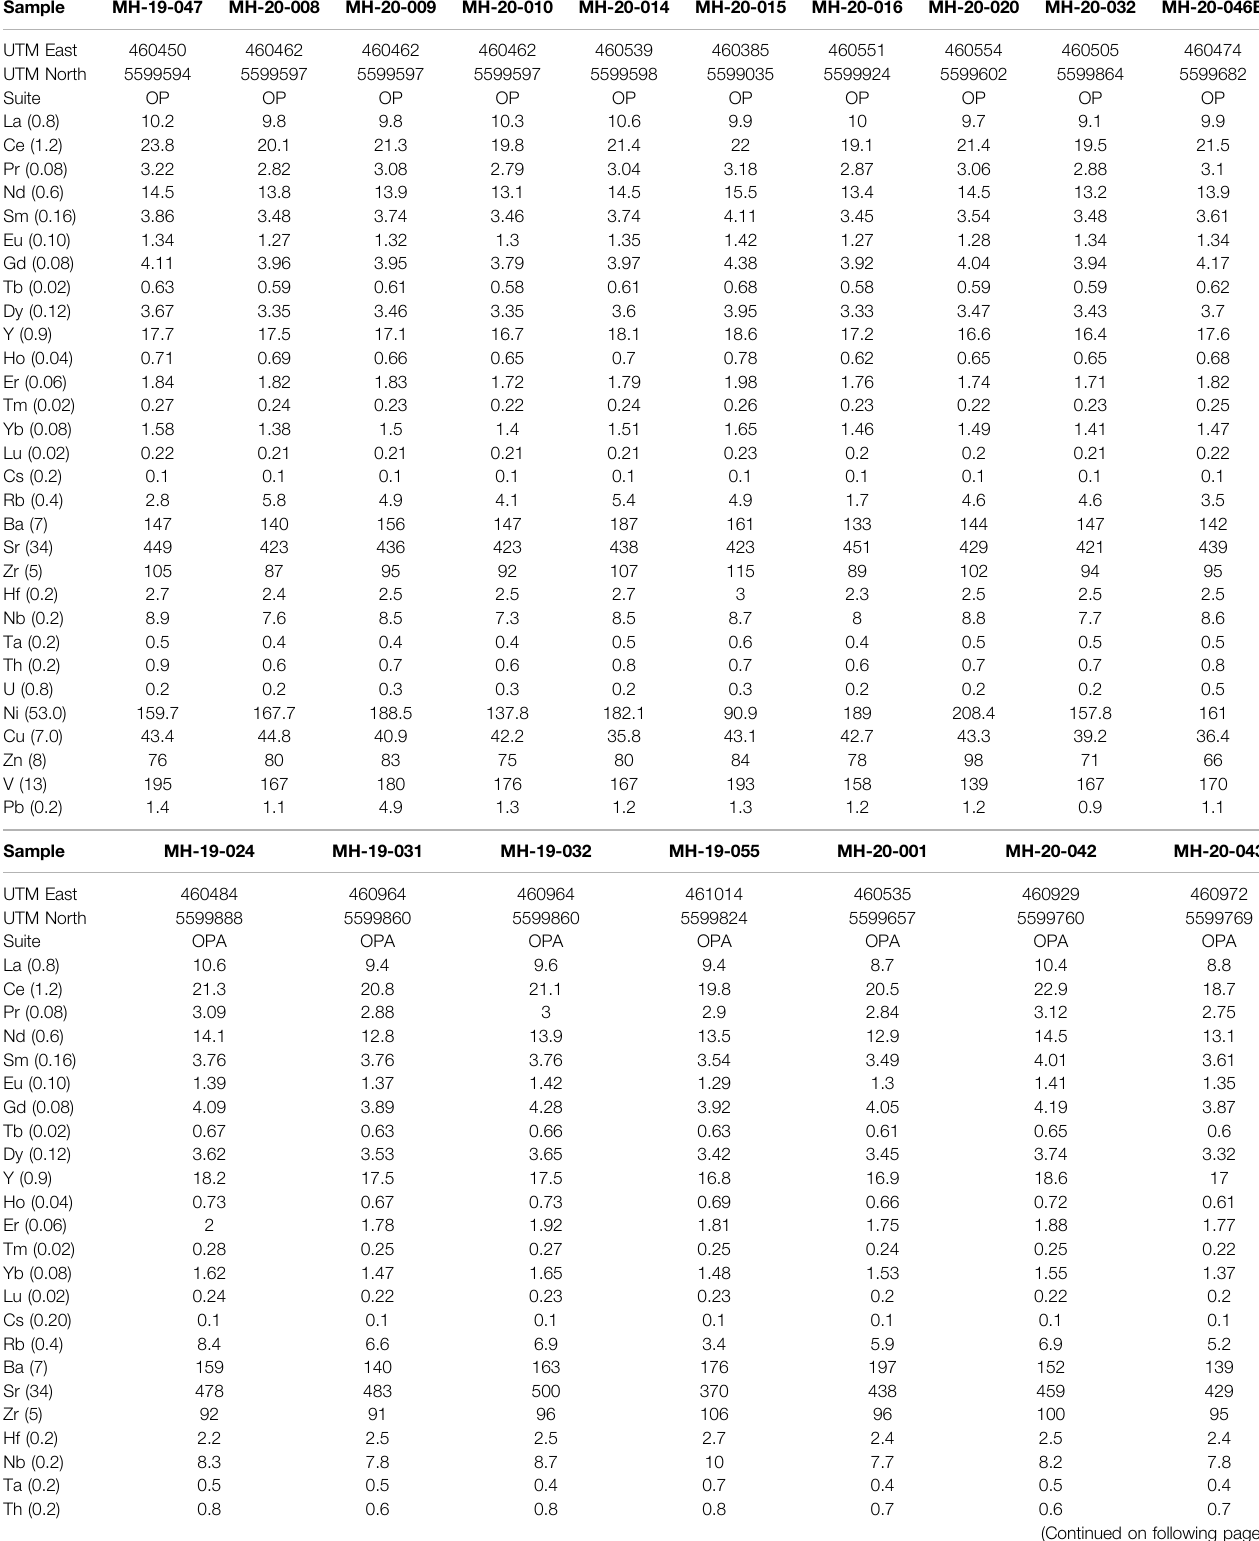
TABLE 2| Whole-rock rare earth and trace element(ppm) compositions ofCracked Mountain volcanic rocks analysed ICP-MS; analytical precision (2s) based on replicates (in brackets).